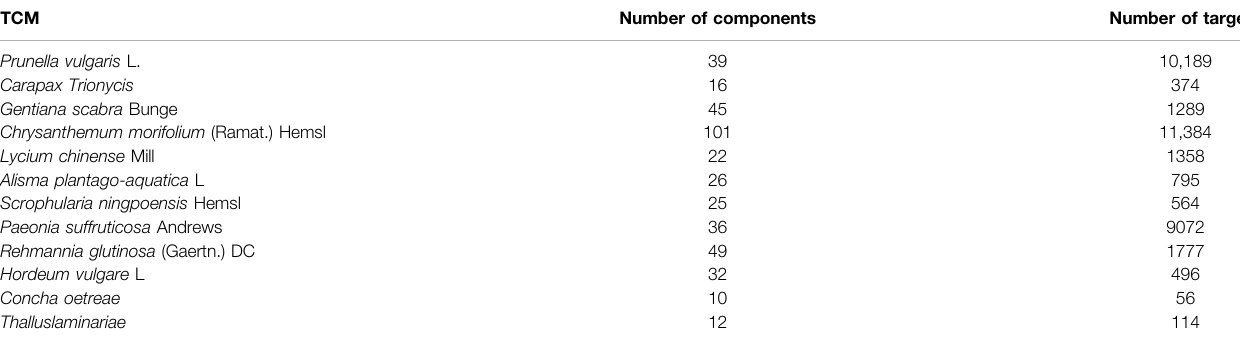
TABLE 2 | Basic data on the components and targets of traditional Chinese medicines. TCM Number of components Number of targets Prunella vulgaris